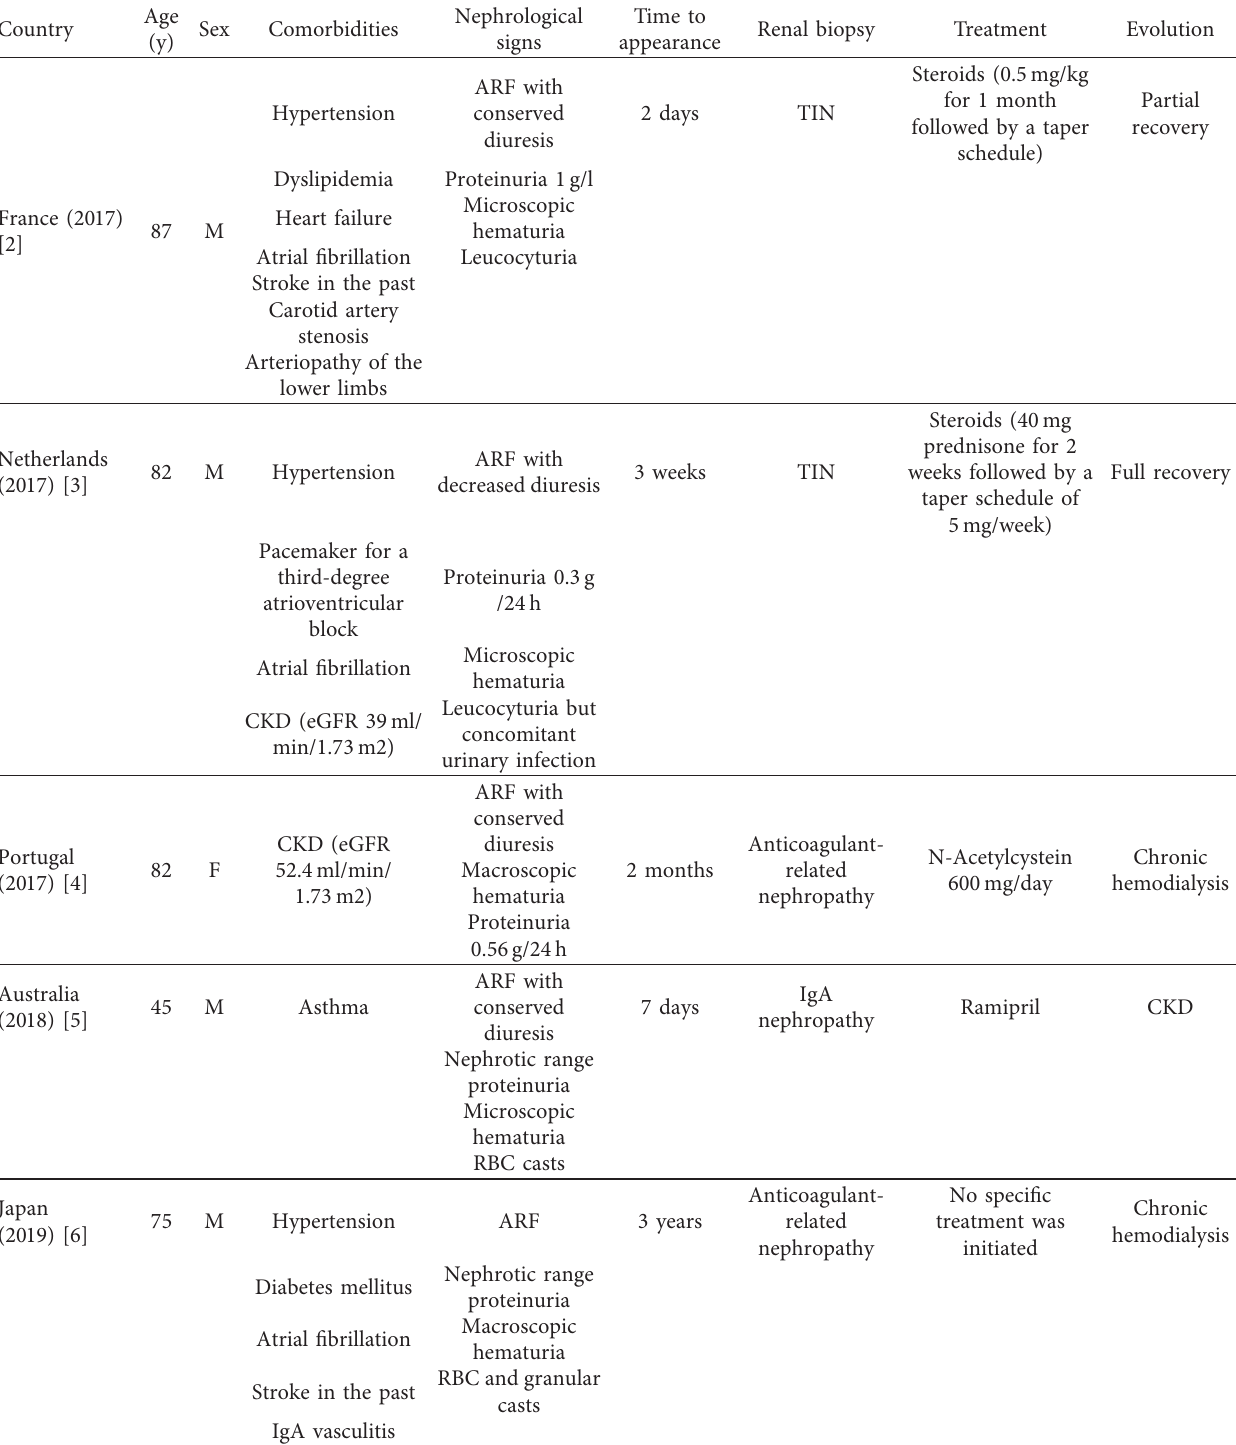
Table 2: Clinical characteristics of the full-published case reports of rivaroxaban-associated acute renal failure.